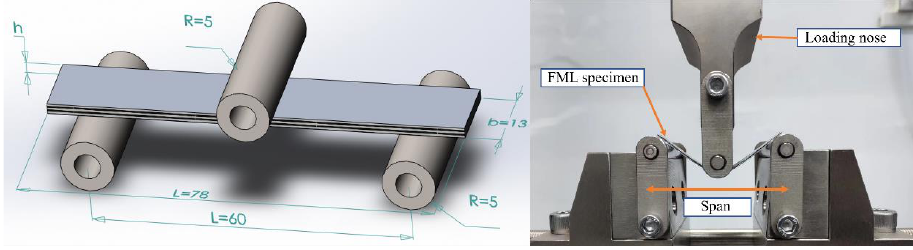
Figure 3. Details of three-point bending experiment and specimen size